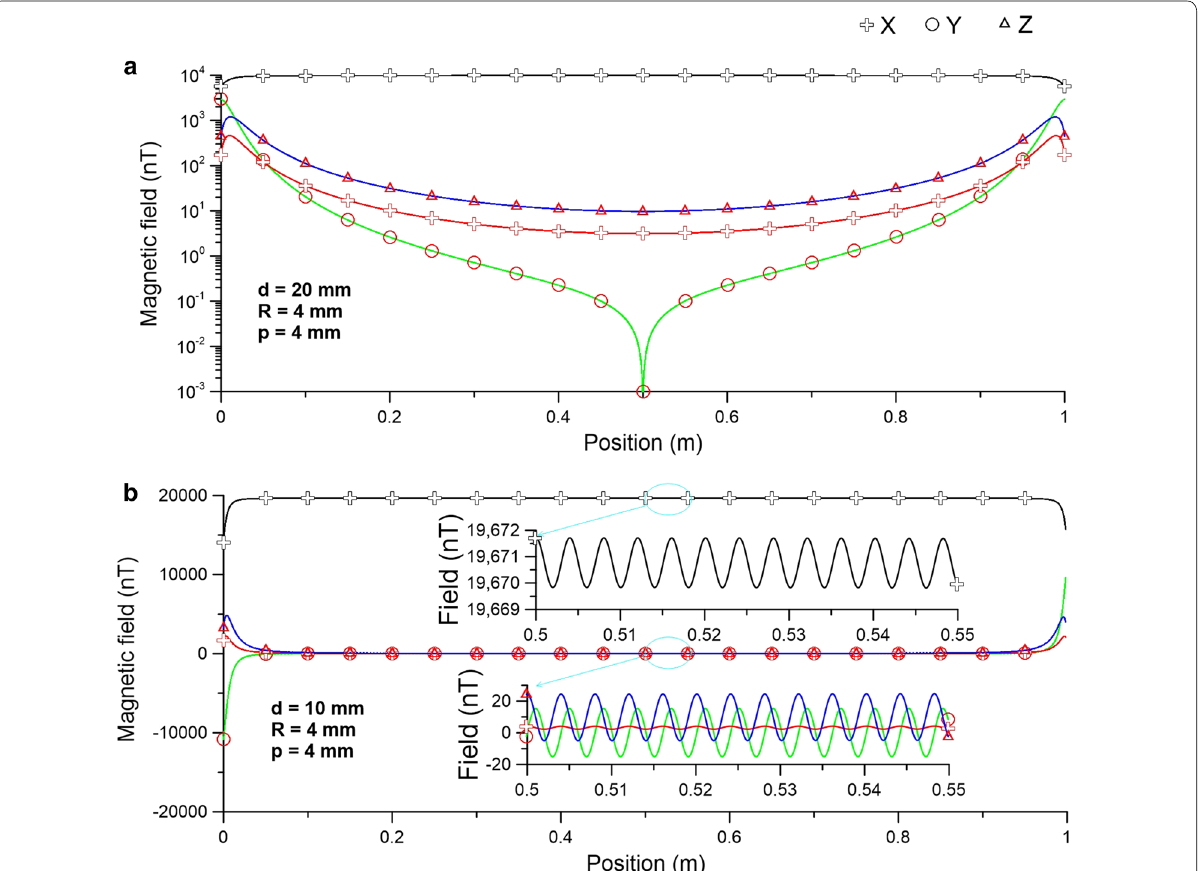
Fig. 3 Magnetic field simulations of single long solenoid at a 10 mm and b 20 mm from the central axis. The black symbol represents the result of conventional solenoid and the red symbol represents the result of a solenoid with a reverse straight wire at solenoid axis. Insets in b show detail measurements over the central 50-cm highlighting period nature of the field, which is caused by the solenoid